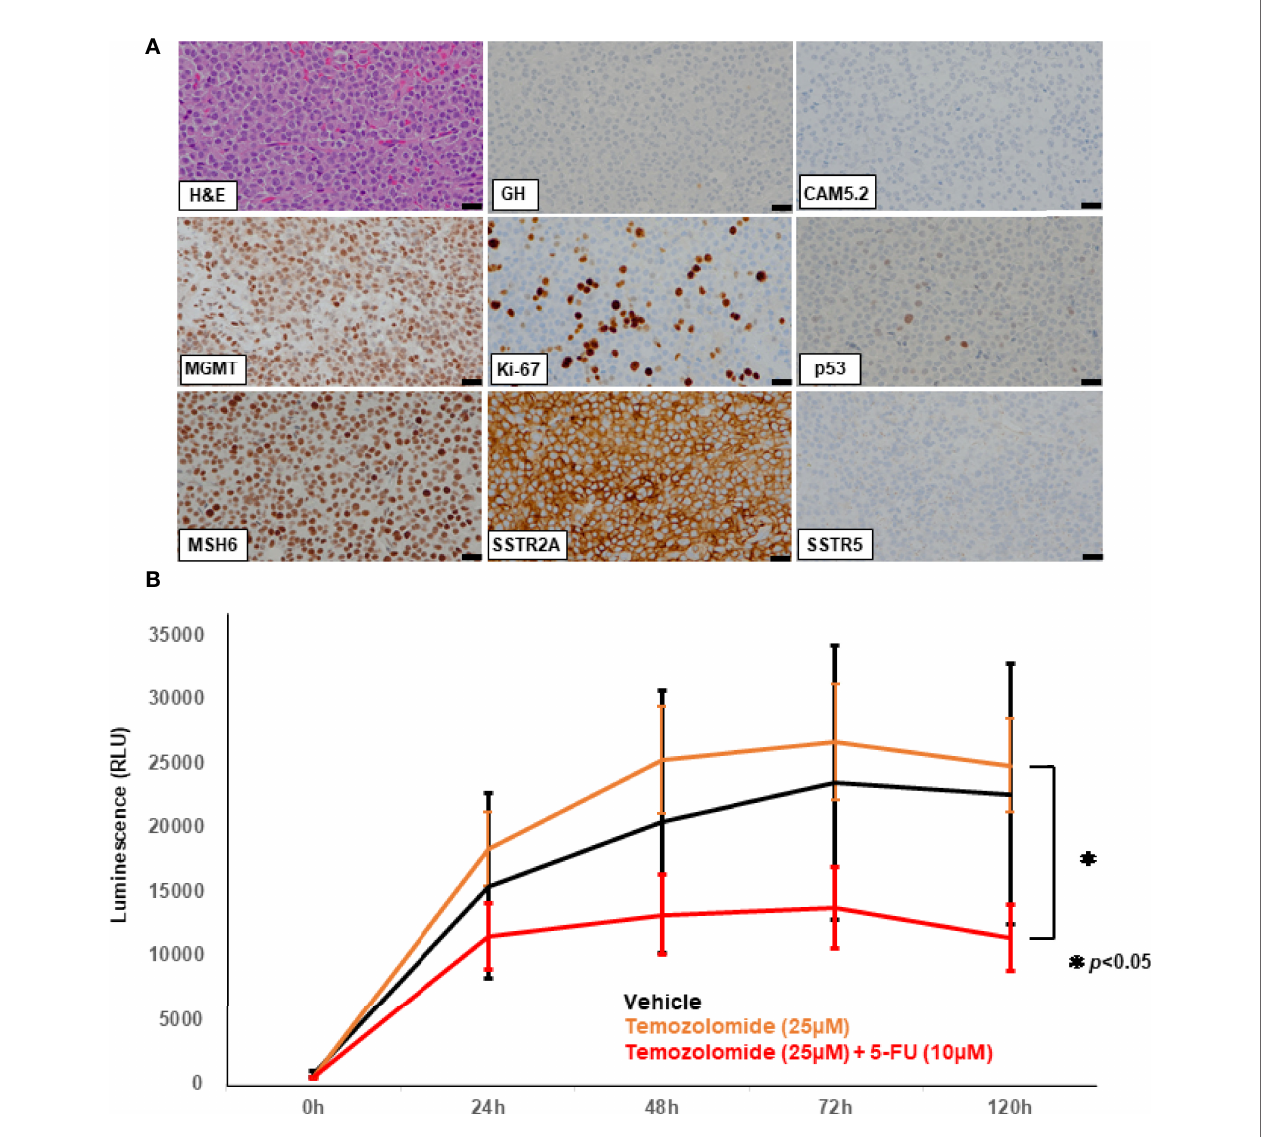
FIGURE 2 | Hematoxylin and eosin (HE) staining and immunohistochemical studies of the specimen from the 5 th surgery (A) using the following antibodies: growth hormone (GH), CAM5.2, O 6 -methylguanine-DNA-methyltransferase (MGMT), Ki-67, p53, MutS Homolog 6 (MSH6), somatostatin receptor (SSTR) 2A, SSTR5. Scale bar represents 20 mm and applies to all the pictures (A) . Patient-derived ex vivo three-dimensional (3D) spheroid culture assay (B) . Cell Viability Assay is shown in the bar graph. X-axis represents the time after drug treatment (hours) while the y-axis represents the value of luminescence (RLU). The luminescence readout is directly proportional to the number of viable cells in culture. Temozolomide (TMZ) combined with 5- fl uorouracil (5-FU) (red line) had signi fi cantly more effect than TMZ alone (orange line). TMZ alone (orange line) showed no effect compared to the vehicle treatment (black line). 50% inhibition concentration (IC50) was used as a reference for setting drug concentration conditions. The p -value of the two-sided test less than 0.05 was considered to represent statistical signi fi cance. RLU: relative light unit. *p <